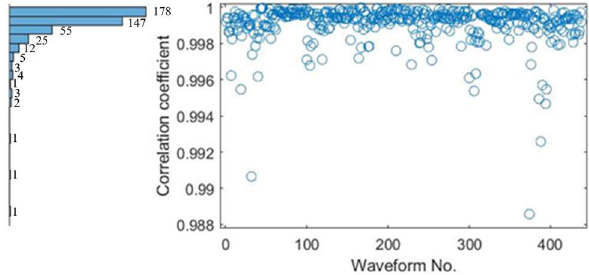
Figure 10. The distribution of correlation coefficients of 438 groups waveforms. Table 2. The correlation statistics result of 438 groups of waveforms.